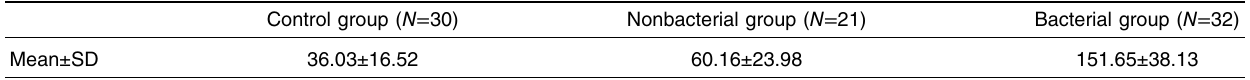
Table 4 Comparison between mean values of serum procalcitonin in the studied groups